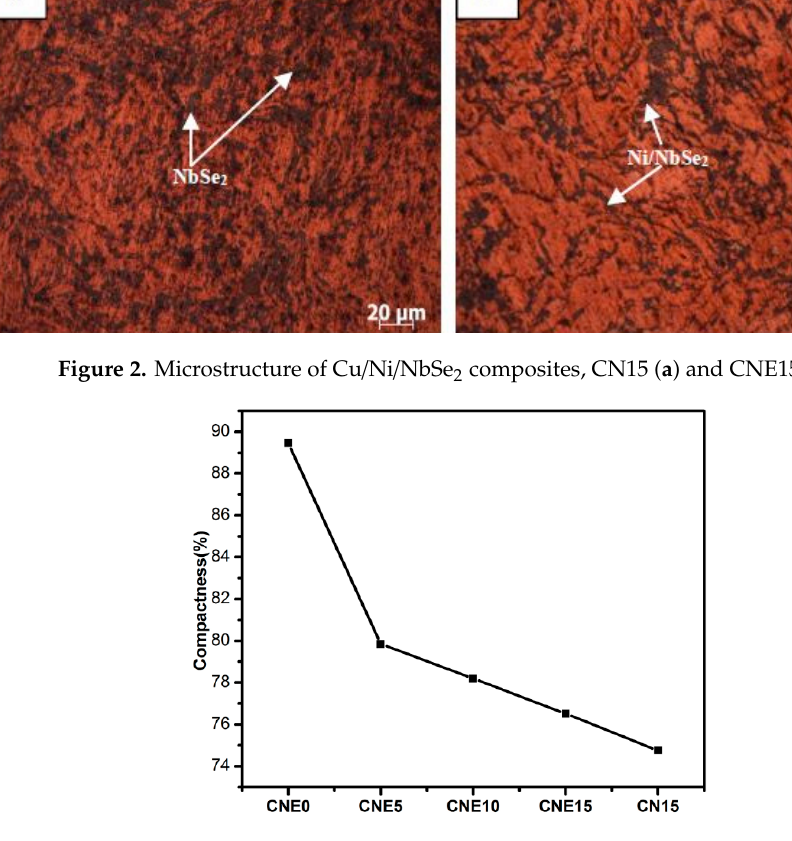
Figure 3. Compactness of Cu/Ni/NbSe 2 composites.